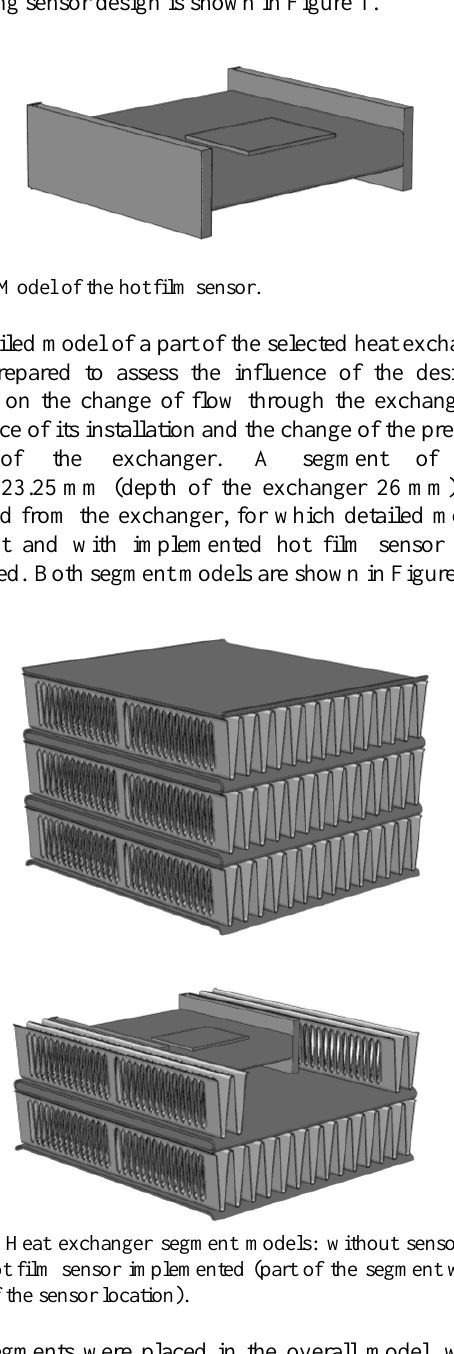
Fig. 4. Pressure drop of the segment models with and without the